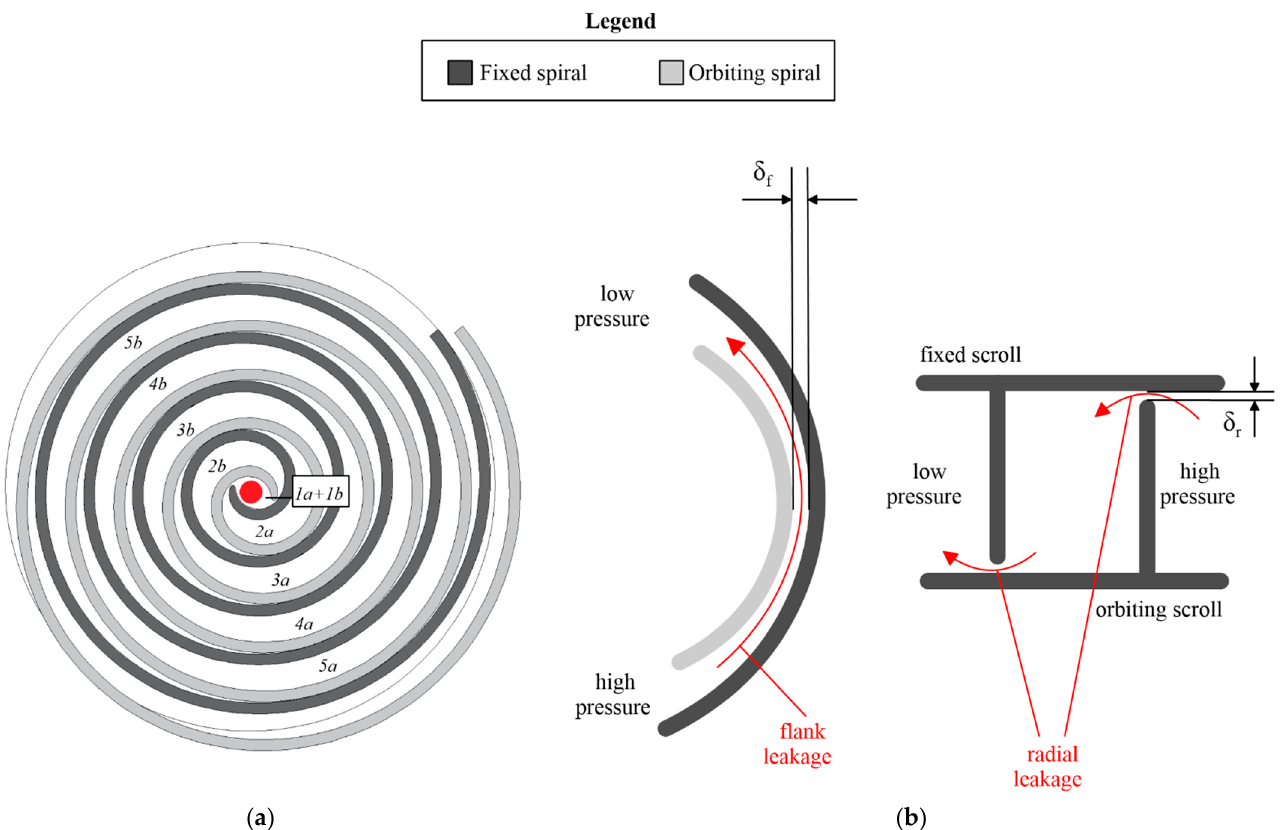
Figure 4. ( a ) Definition of the expander working chambers: the fluid expands simultaneously in two symmetrical volume sequences (indicated by the subscripts a and b); ( b ) flank leakage and radial leakage in scroll expanders. The flow leakages were identified according to the approach of [35,36].